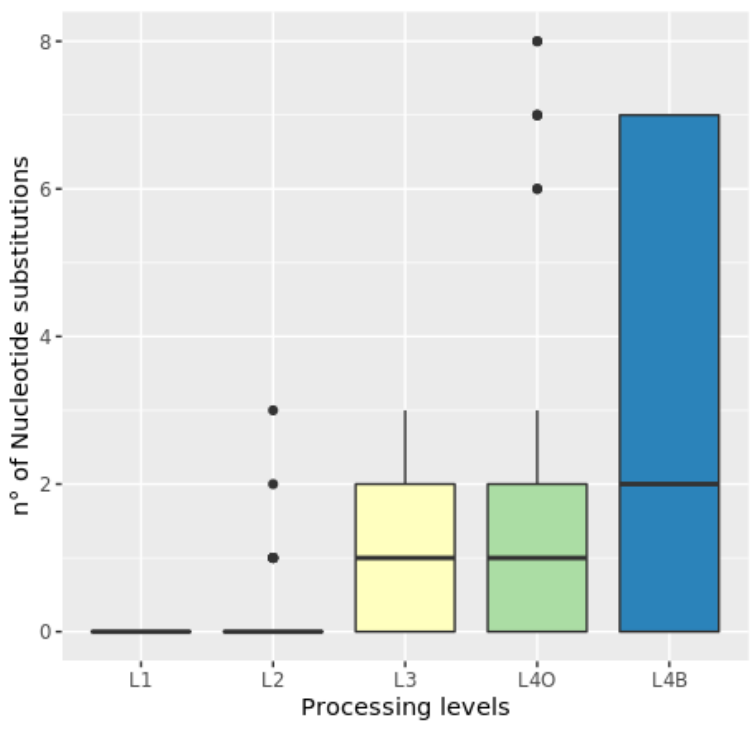
Figure 2. Box plot of nucleotide substitutions at the four processing levels (L1 – L4).